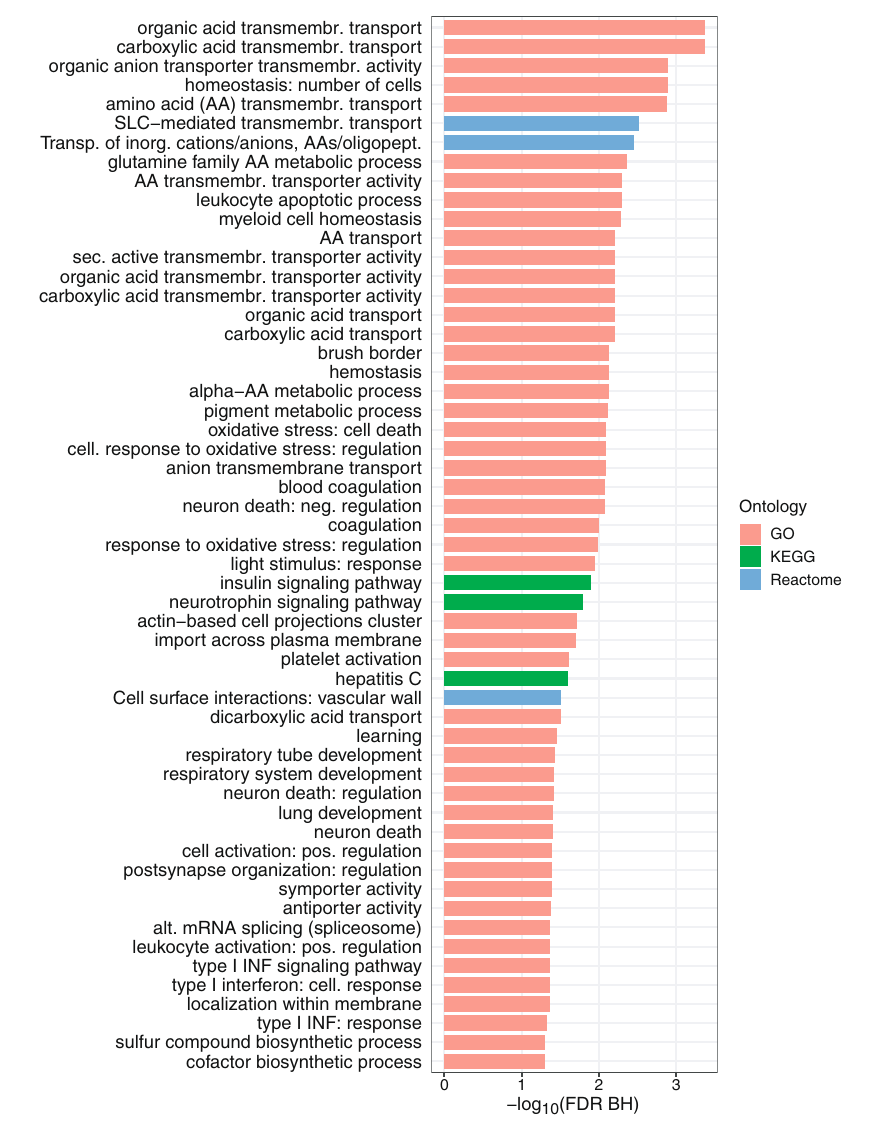
Fig. 7 GO terms and KEGG and Reactome pathways that were enriched for urate-associated CpGs. Signi fi cance level was set at false discovery rate <0.05. GO Gene Ontology, KEGG Kyoto Encyclopedia of Genes and